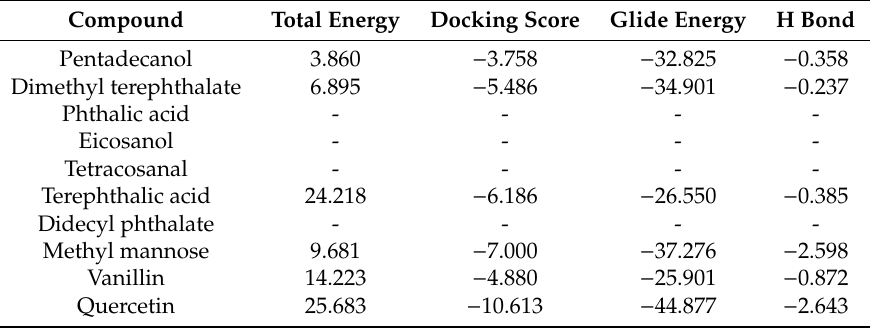
Table 4. Binding analysis of 10 selected compounds identified from ethanolic extracts of Calpurnia